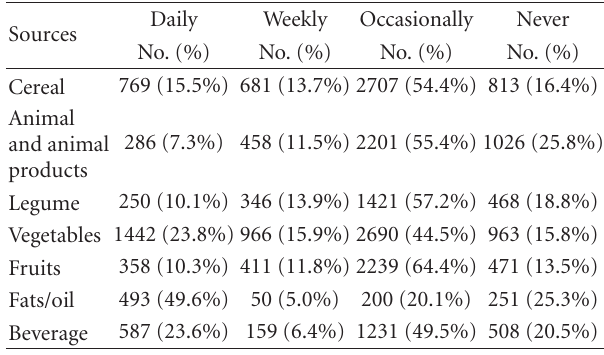
Table 4: Food variety of HIV seropositive patients ( n = 497).